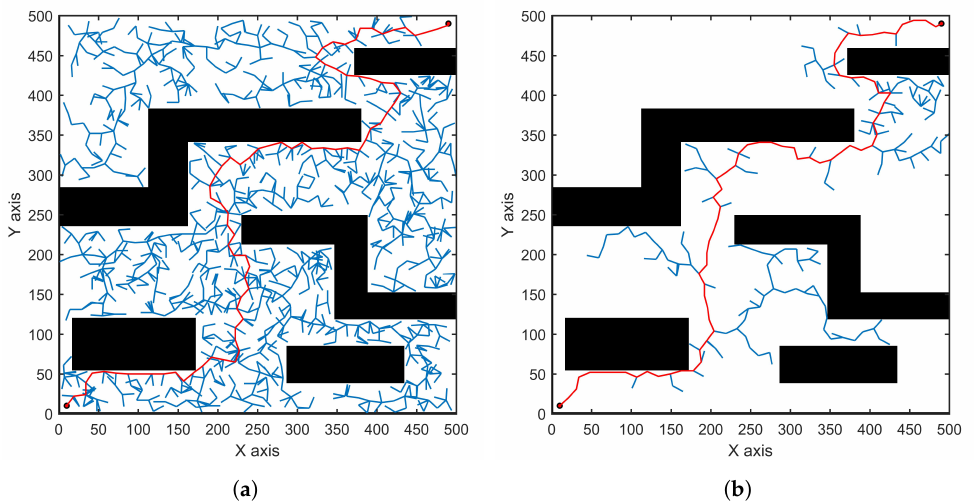
Figure 1. Performance comparison between Basic-RRT and CSA-RRT in the same environment. ( a ) Performance of Basic-RRT. ( b ) Performance of